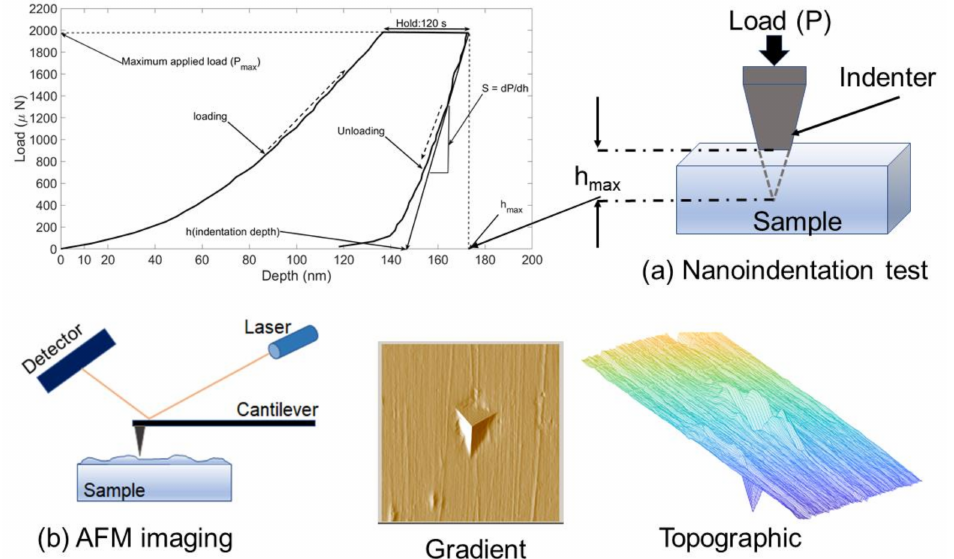
Figure 1. Schematic representation of ( a ) nanoindentation test, ( b ) atomic force microscopy (AFM)